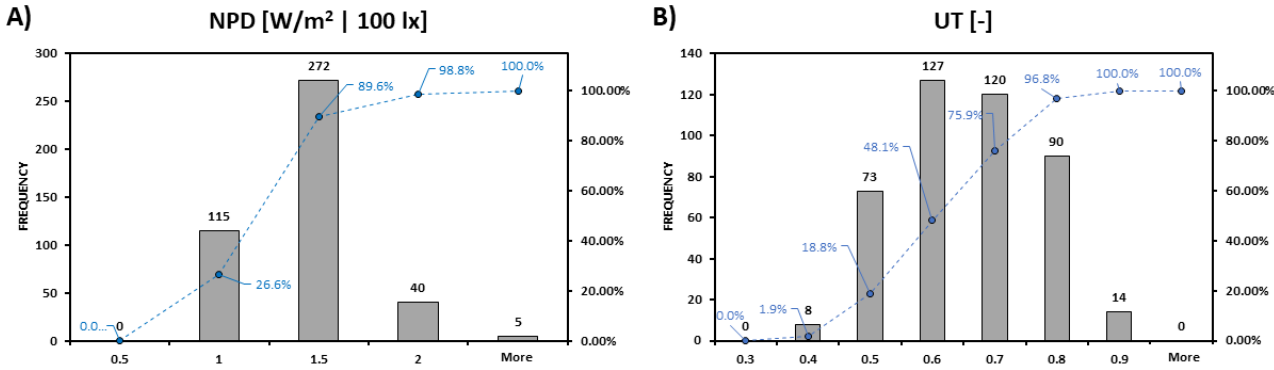
10 of 16 Figure 6. The histograms presenting the distribution of obtained results for: ( A )—Upward Light Ratio and ( B )—Upward Flux Ratio. Taking into account the obtained results of the UFR parameter, it should, fi rst of all, be noted that the obtained values, even for extensive lighting oversize (140%, MF = 0.71) and large tilt of the luminaires, are lower than the requirements for zone E4. The UFR values are most often in the range of 2 to 4. Only in 13 cases of the obtained values exceed 5. This means that 97% of the cases meet the requirements for the E2 zone, and 100% are suitable for the E3 and E4 zones (Table 1). It is because, in all the luminaires used, the